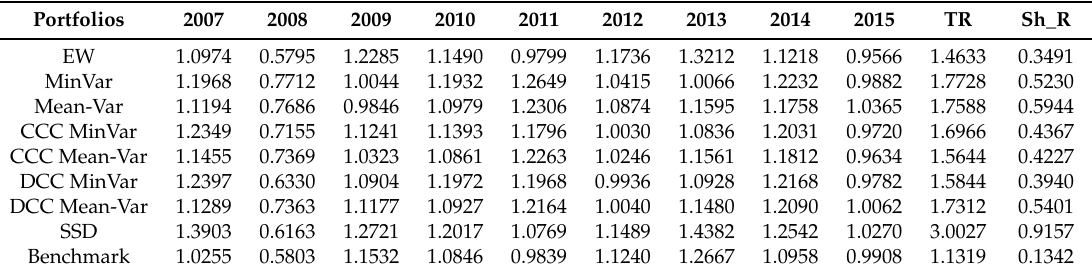
Table 5. Yearly compounded returns, Total compounded Return (T_R) and Sharpe Ratio (Sh_R) for S&P 100 stocks (t =